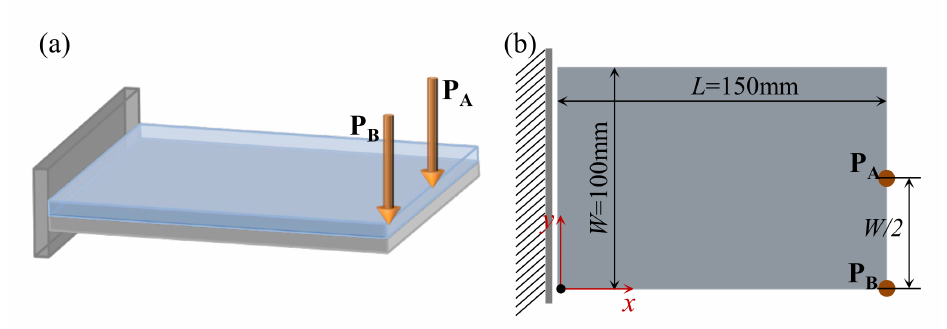
Figure 5. A cantilever composite plate. ( a ) 3D view. ( b ) Top view of the composite